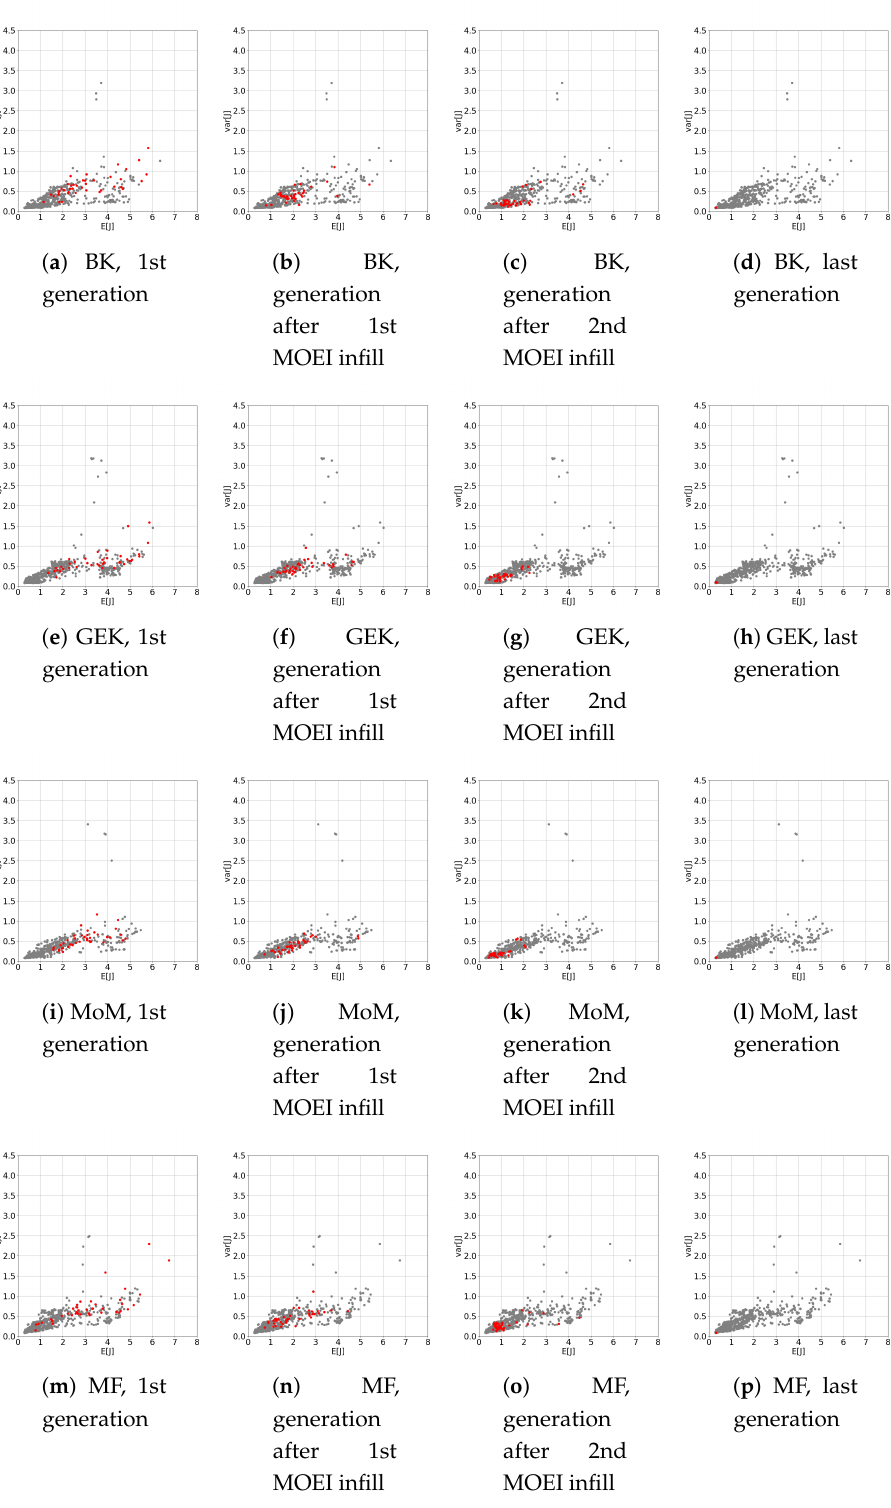
Figure 6. Evolution of the convergence for BK, GEK, MoM, and MF. Red color highlights designs belonging to the first generation, generations after the first and the second MOEI infill, and the last one. Other designs are in grey